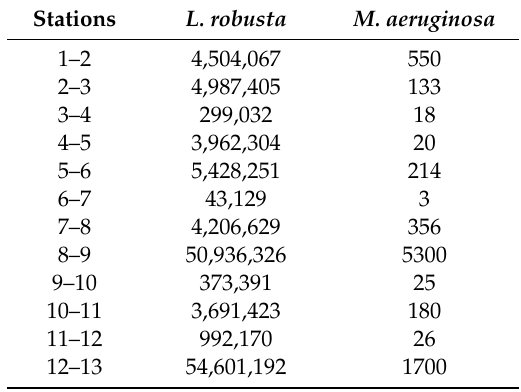
Table 3. Cyanobacteria density of L. robusta (cells / mL) and M. aeruginosa (colonies / mL) during sampling. Stations L.